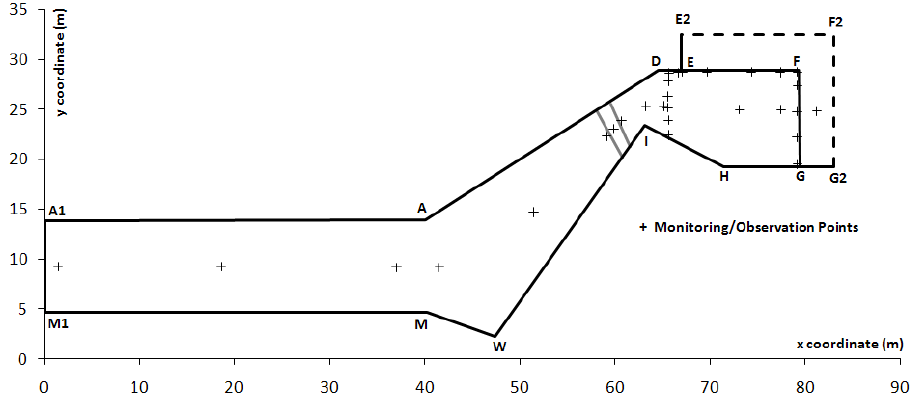
Figure 8. Modeled area and monitoring/observation points.